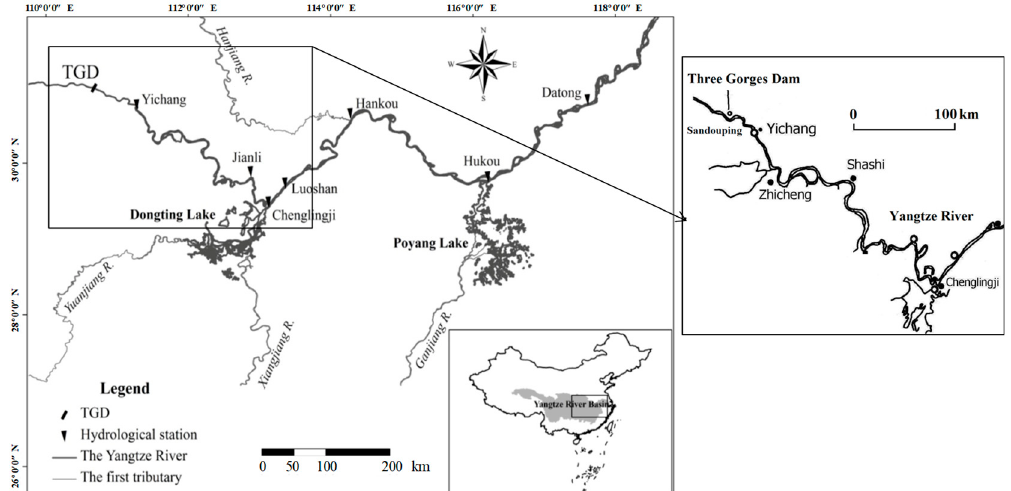
Figure 1. Location of the TGD on the Yangtze River. (The left part of the figure is based on [23]). Observations of the sedimentation pattern in the dam area of a typical section